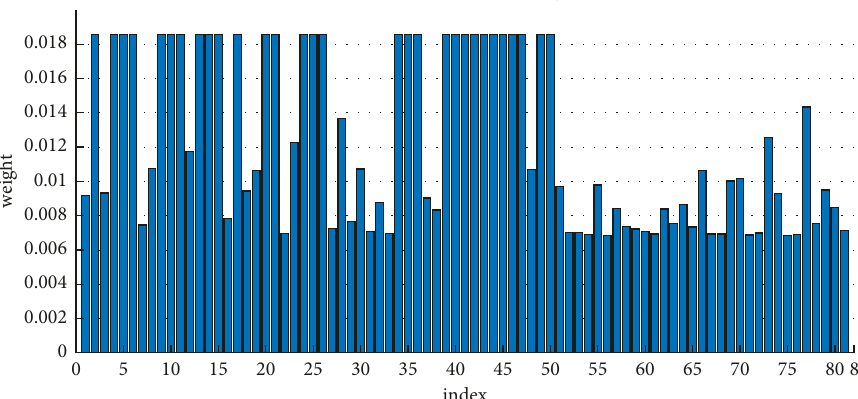
Figure 3: The weights of 81 indexes of three kinds of hickories with nutrition, texture, and